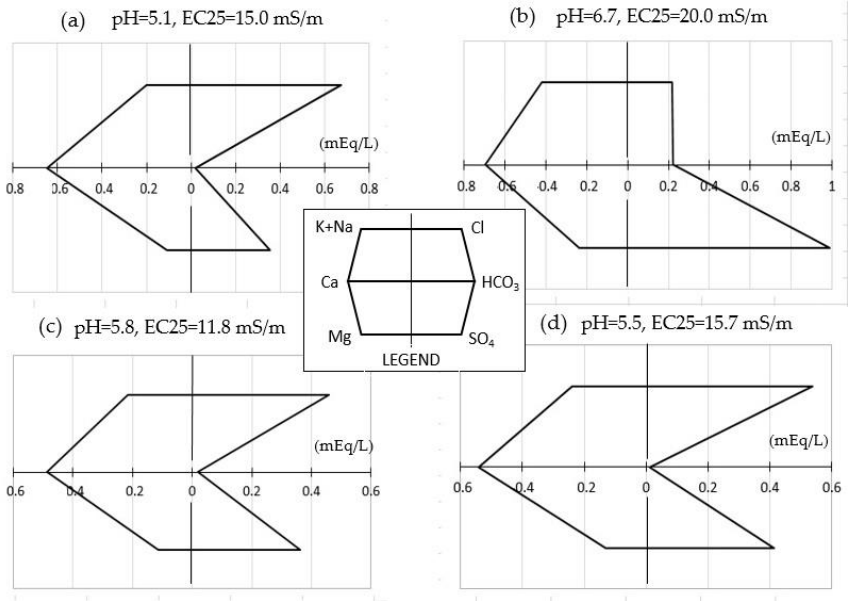
Figure 2. Stiff diagrams of sampled water in ( a ) Tama River and ( b ) Sendachi River, and at the ( c ) surface and ( d ) 400 m of site MD in Lake Tazawa.